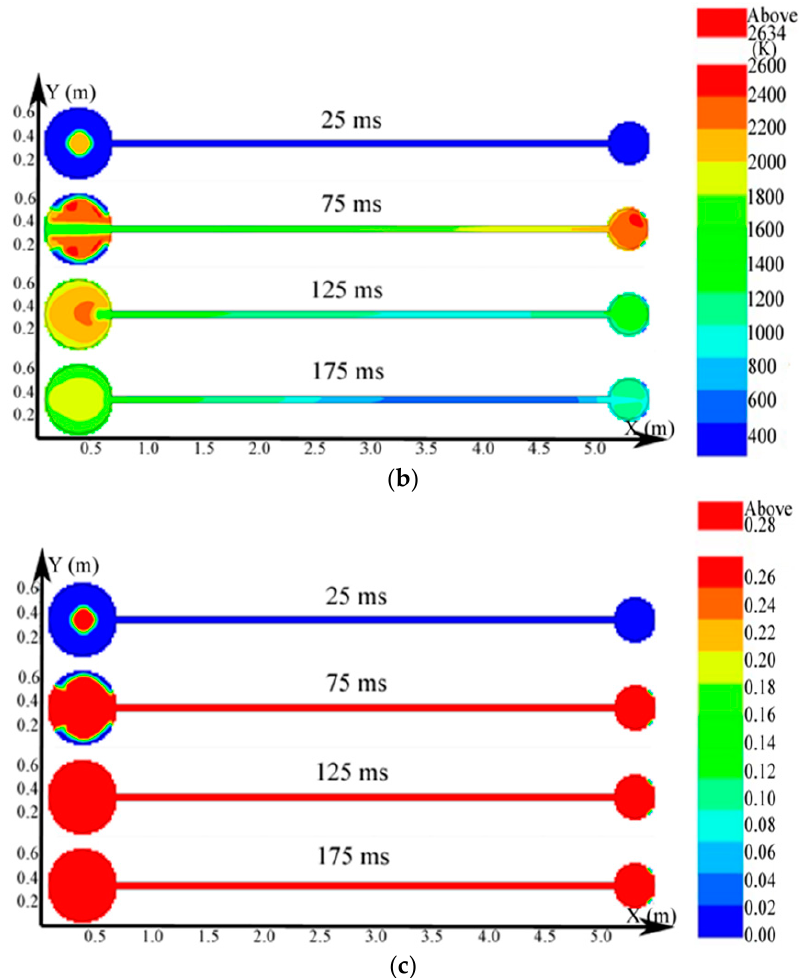
Figure 10. Contours of the natural gas explosion parameters in the big vessel connected to the small vessel. ( a ) Distribution of pressure; ( b ) distribution of temperature; ( c ) distribution of the concentration of products.